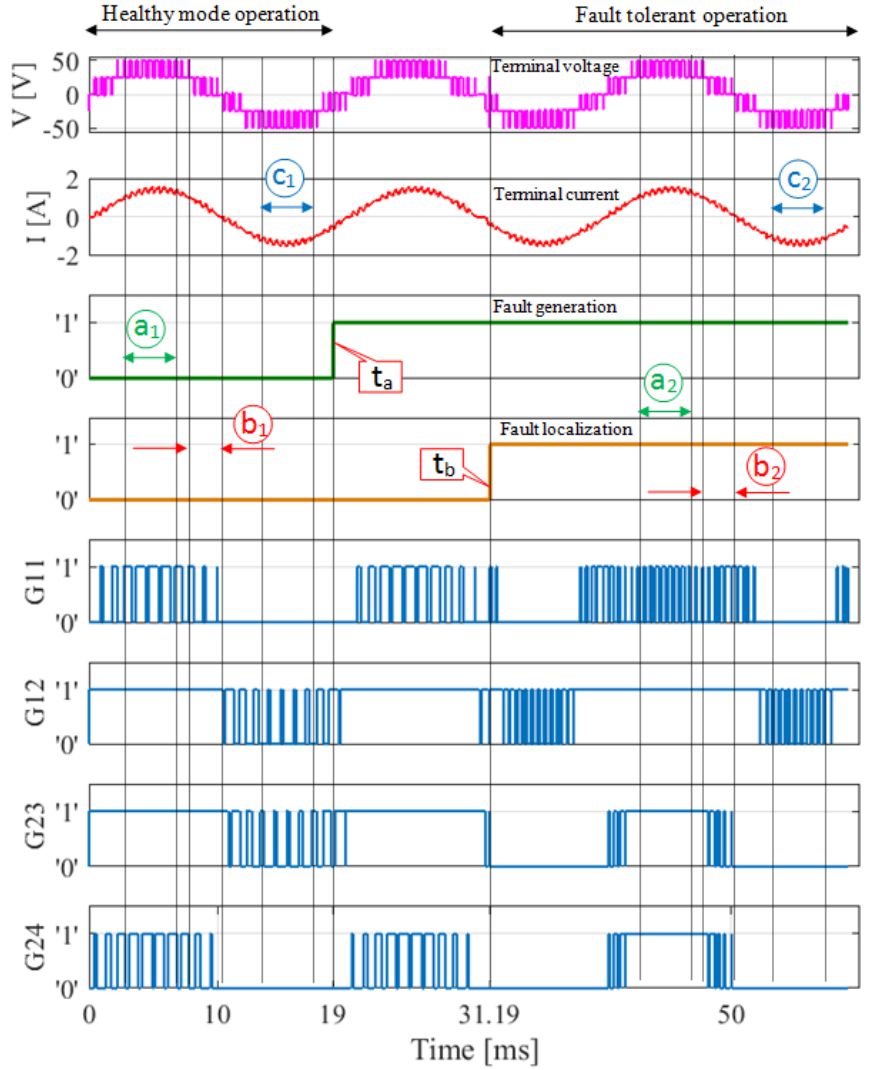
Figure 9. Simulation results for fault-tolerant operation of the inverter in the case of a short-circuit fault event in S22.